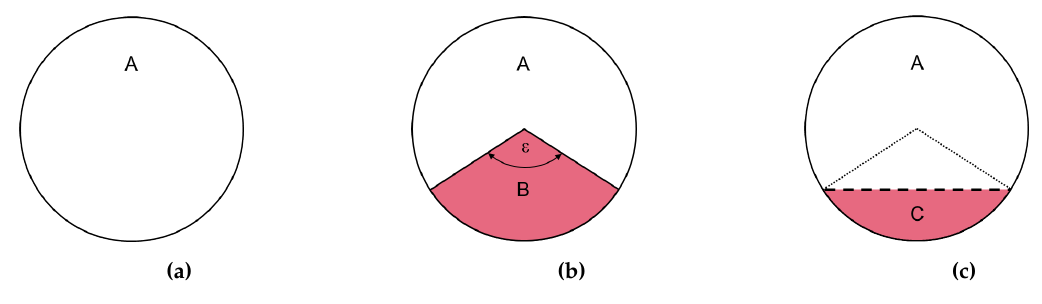
Figure 4. Different inflow situations at the fan face; A: undistorted flow, B: distorted flow, C: boundary layer. ( a ) Undistorted inflow; ( b ) Inflow with distorted sector, typical PCM application; ( c ) Inflow with asymmetric boundary